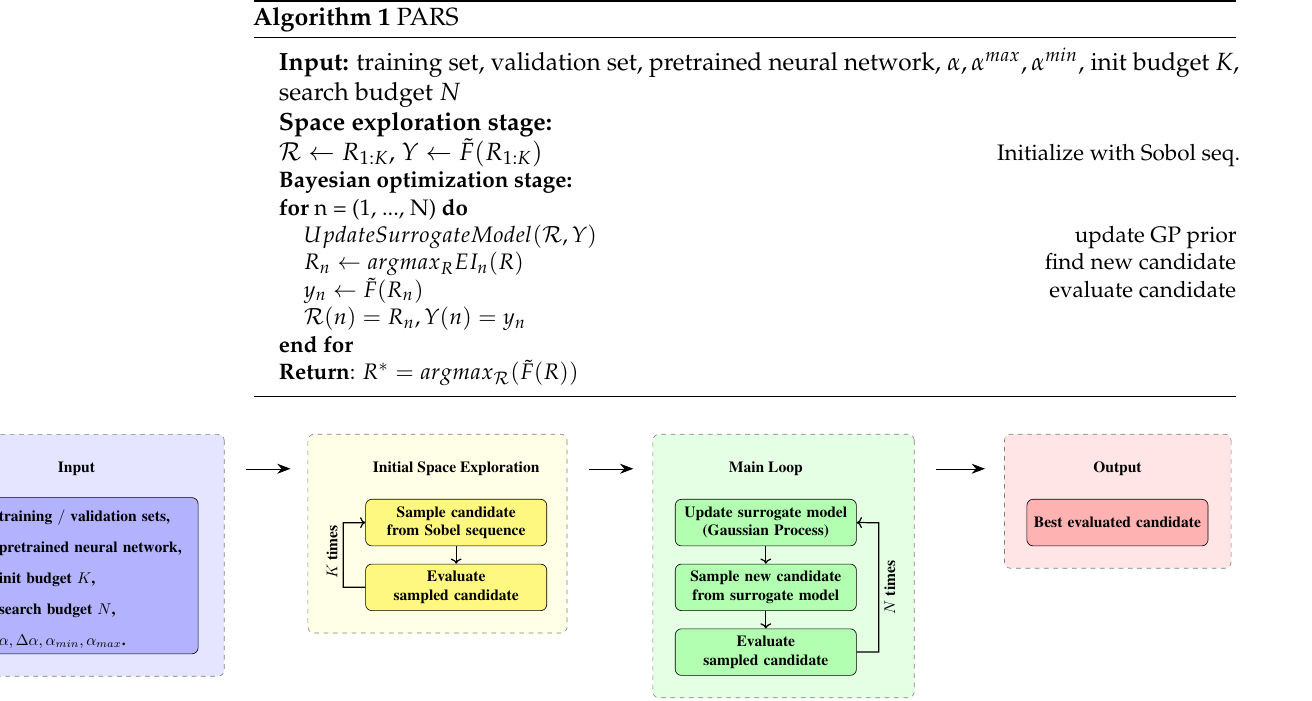
Figure 4. Flowchart for the proposed rank search procedure in the single-rank case (Algorithm